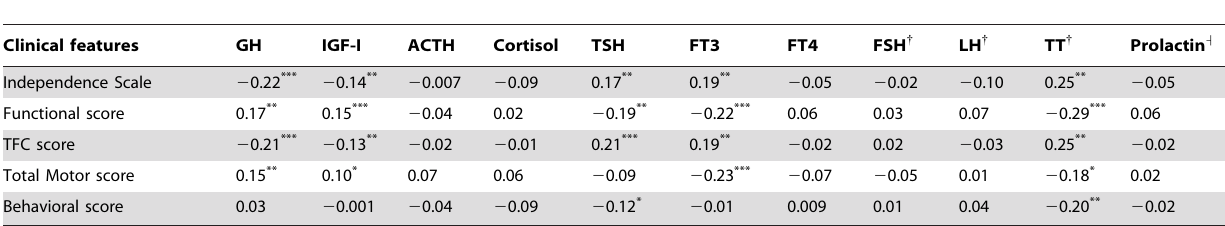
Table 3. Relationship between disease severity and pituitary axis